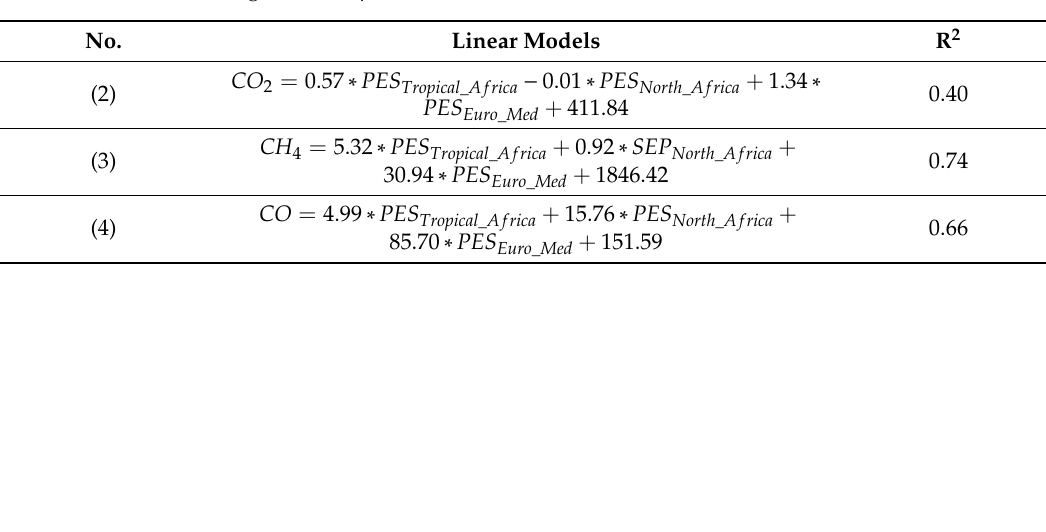
Figure S1: Average PES in each cluster. Logarithmic color scale shows the log 10 of residence time, i.e., the PES below 5000 m. Figure S2: Average PES in each cluster in the boundary layer. Logarithmic color scale shows the log 10 of residence time.